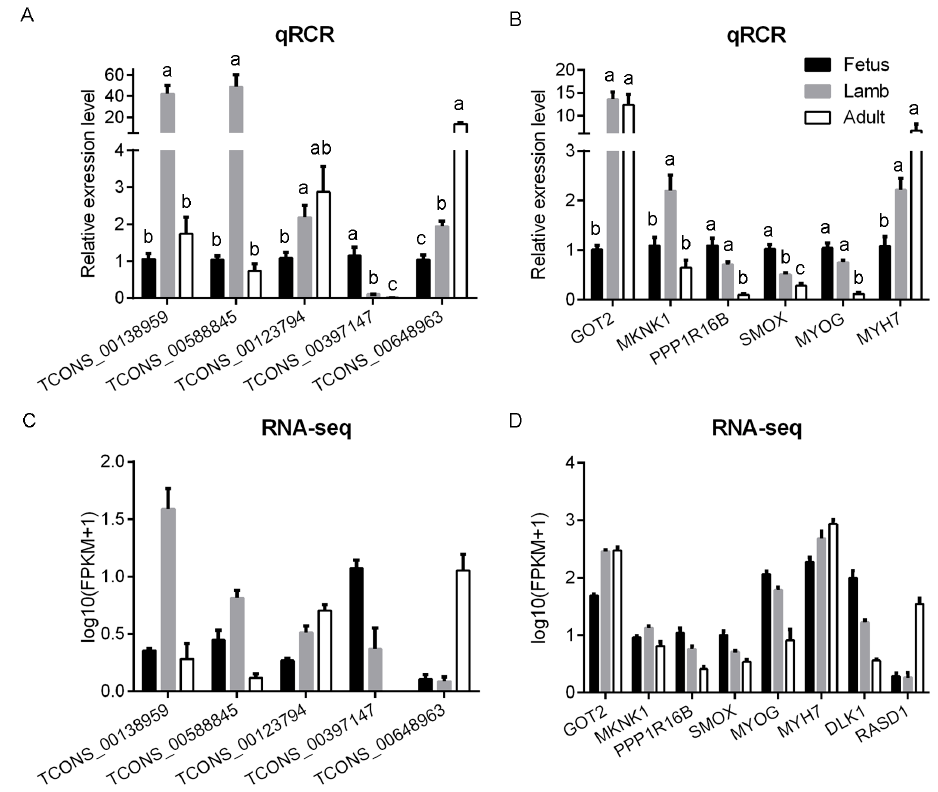
Figure 5. The verification of expression level of differentially expressed transcripts at fetus, lamb and adult stages measured by qRT-PCR and RNA-Seq, respectively. ( A ) The relative expression level of differentially expressed lncRNAs in different stages determined by qRT-PCR. ( B ) The relative expression level of DEGs, including GOT2 (glutamic-oxaloacetic transaminase 2), MKNK1 (MAP kinase interacting serine/threonine kinase 1), PPP1R16B (protein phosphatase 1 regulatory subunit 16B), SMOX (spermine oxidase), MYOG (myogenin) and MYH7 (myosin heavy chain 7) in different stages determined by qRT-PCR. ( C ) The relative expression level of the differentially expressed lncRNAs in different stages determined by RNA-Seq, respectively. ( D ) The relative expression level of DEGs in different stages determined by RNA-Seq, respectively. The expression of delta-like1 homologue gene (DLK1, which is enriched in fetal muscle) and ras related dexamethasone induced 1 (RASD1, which is enriched in lamb muscle at 12 weeks of age [28]) were also showed. The relative expression level of the differentially expressed lncRNAs and DEGs in muscle was determined by qRT- PCR and normalized to the expression of hypoxanthine phosphoribosyltransferase 1 (HPRT1). The qRT-PCR data were represented as the mean ± SEM of three biological and technical replicates. Columns with different letters are significantly different at p < 0.05. The RNA-Seq data represented